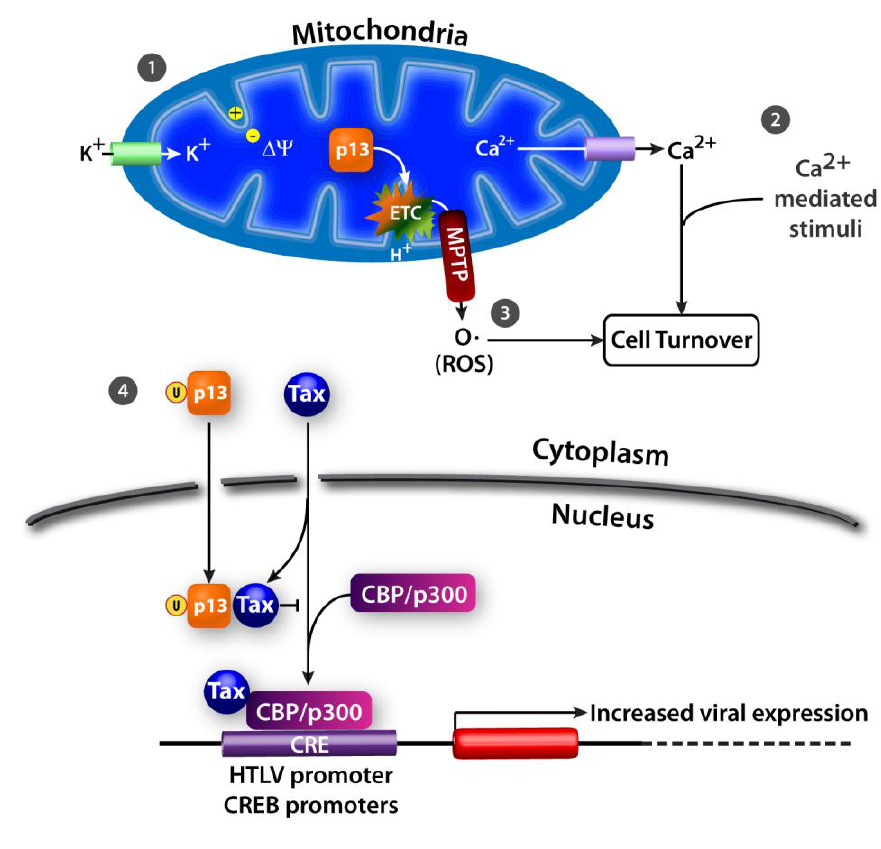
Figure 4. Functions of p13. In mitochondria, p13 mediates ( 1 ) K + influx, inner mitochondrial membrane potential, and electron transport chain activity to affect ( 2 ) Ca 2+ signaling and ( 3 ) ROS production. ( 4 ) In the presence of Tax, p13 is ubiquitinated and translocates to the nucleus. In the nucleus, p13 inhibits Tax-CBP/p300 complex formation to decrease transcription of cellular and viral